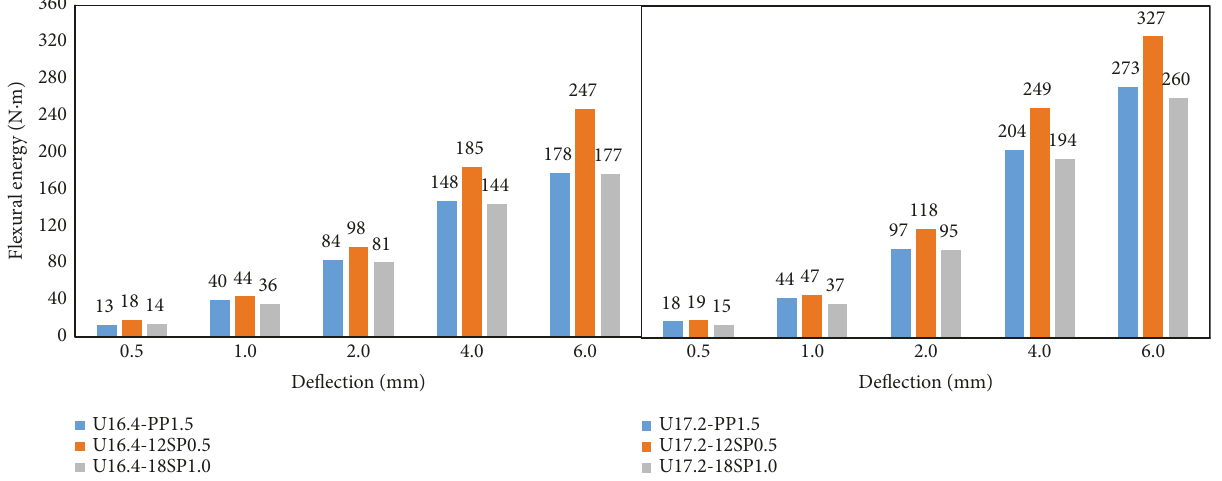
Figure 5: Flexural energy absorption values calculated according to the curve in Figure 4.